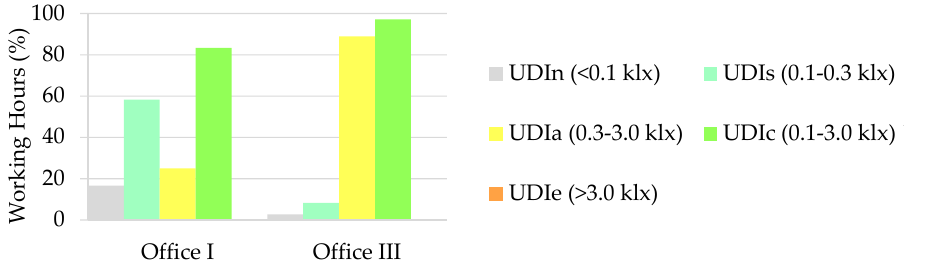
Figure 14. Percentage of working hours within specific indoor illuminance levels (UDI ranges) measured at the desk (horizontal plane) for the office rooms I and III during the days with the artificial lighting turned off (weekends) of the heating period.